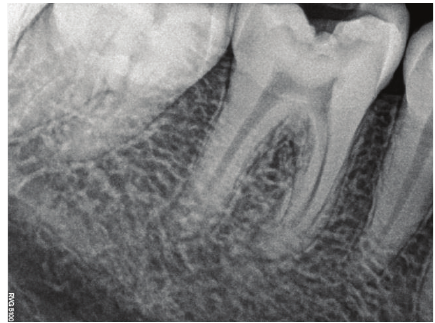
Figure 29: Preoperative RVG 36.